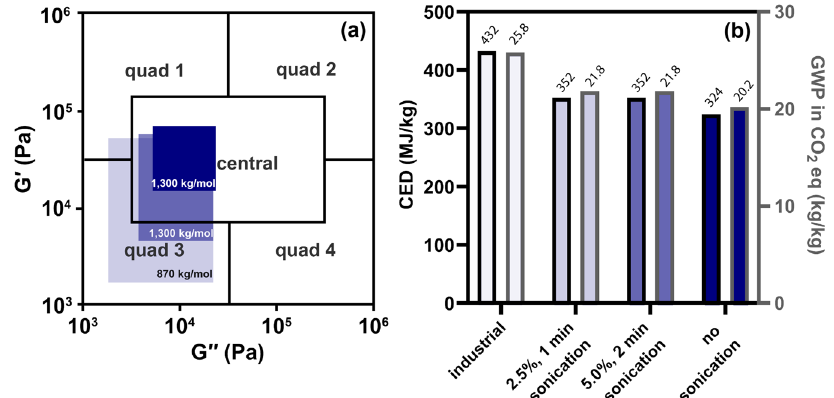
Fig. 5 Adhesive properties and life cycle assessments. Plots of storage (G ′ ) versus loss (G ′′ ) moduli for poly(2-ethylhexylacrylate) ( a ), including visualization of Chang ’ s viscoelastic window, and of the cumulative energy demand (CED) and global warming potential (GWP) for each route (